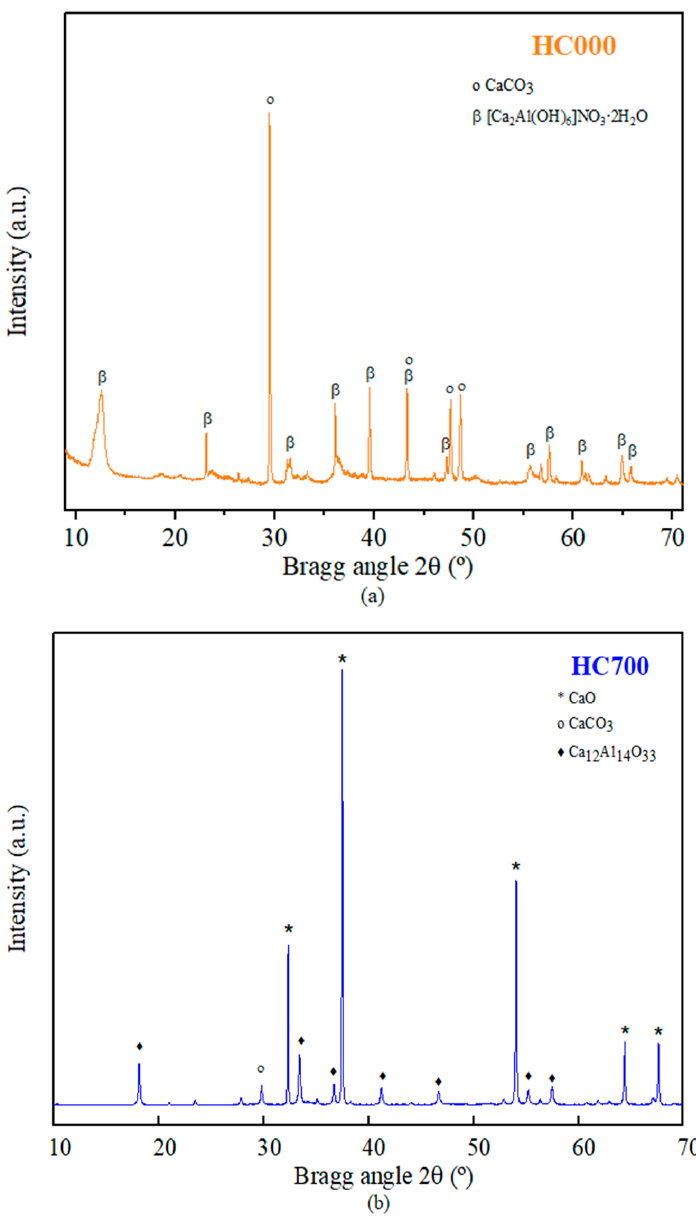
Figure 3. X-ray diffraction profiles of ( a ) HC000 and ( b ) HC700.